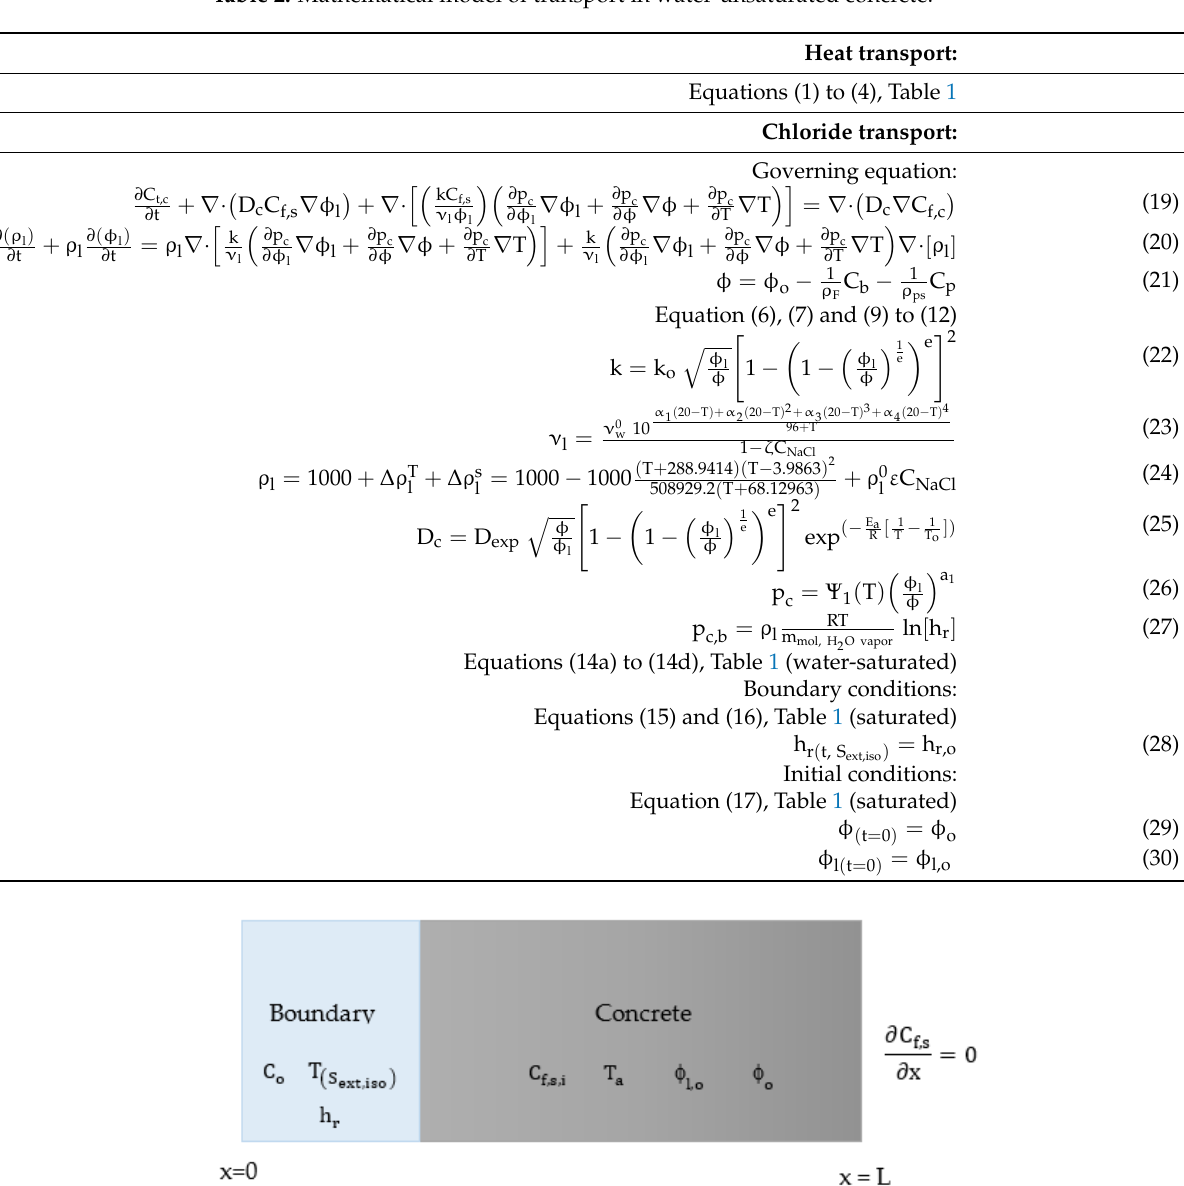
Table 2. Mathematical model of transport in water-unsaturated concrete.